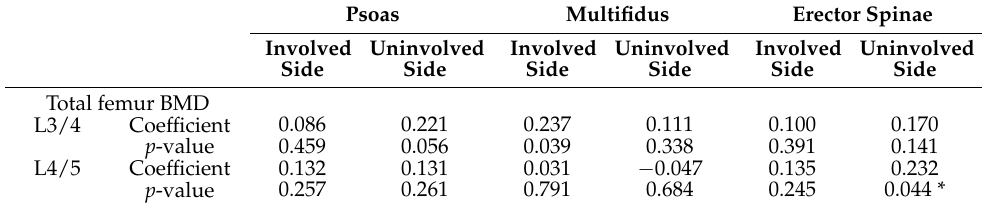
Psoas Multifidus Erector Spinae Involved Uninvolved Involved Uninvolved Involved Side Side Side Side Side